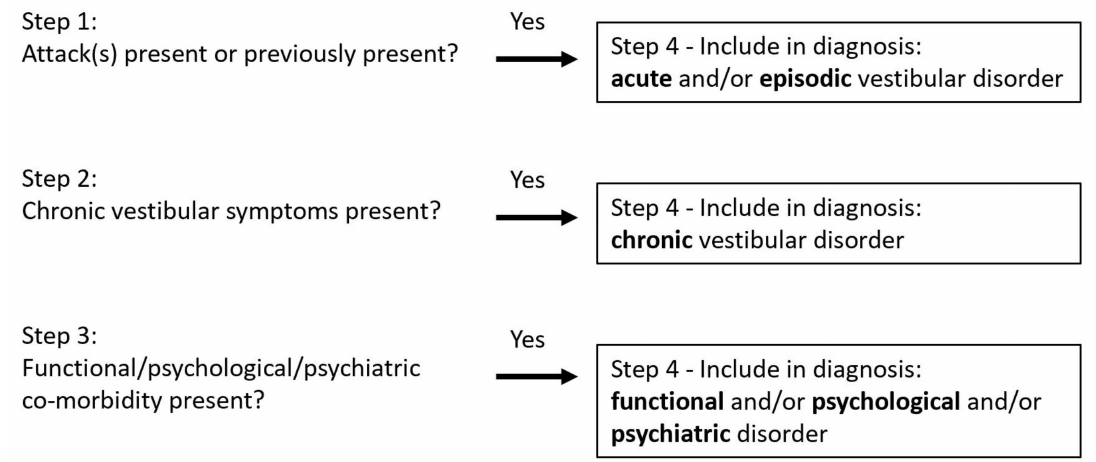
Figure 2. Using the 4-step approach to make a comprehensive diagnosis. Steps 1 to 3 investigate whether specific disorders might be added to the diagnosis. Finally, all co-occurring disorders are included in the diagnosis (step 4). Note: since the 4-step approach is aimed at patients presenting with non-acute vestibular symptoms, the ‘acute vestibular disorder’ mainly refers to a previous acute event (e.g., an acute unilateral vestibulopathy/vestibular neuritis that occurred five months